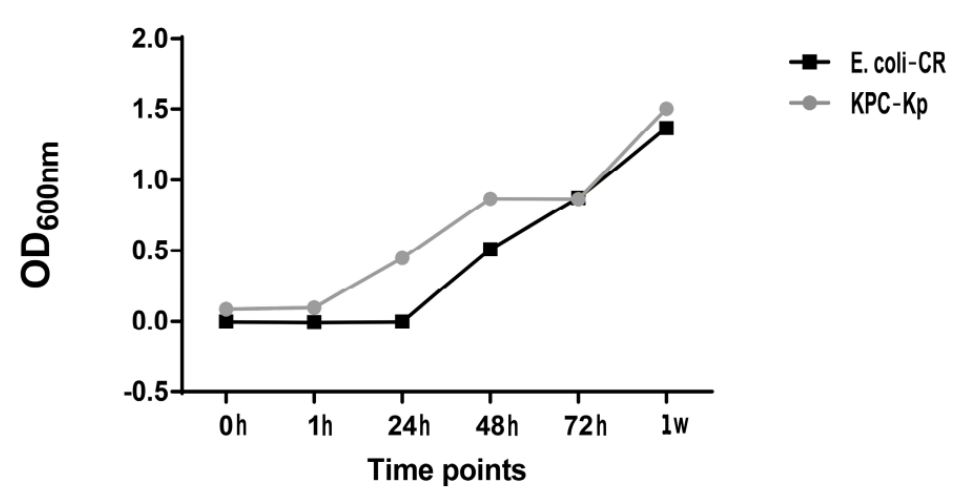
Figure 1. Post-paracentesis AF infection with Carbapenem-resistant Enterobacterales time course, without hA-MSCs. The proliferation of KPC-Kp bacteria begins its exponential phase after 1 h of treatment; for E. coli-CR , proliferation starts after 24 h.